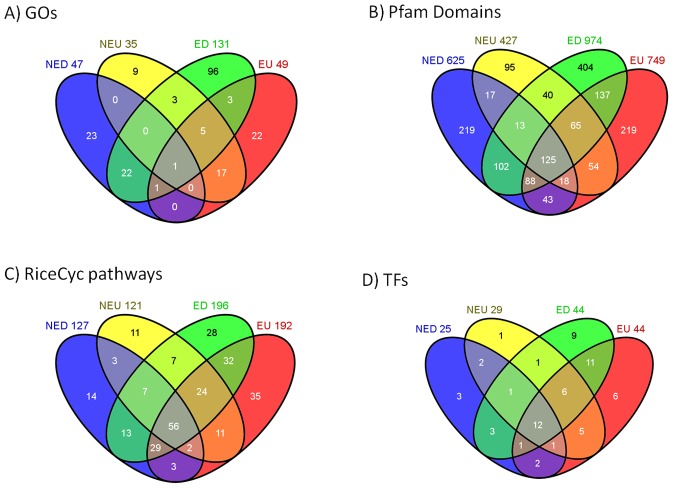
Four way venn diagrams depicting overlap of different characteristics between the clusters NED, NEU, ED and EU.A) GO terms analyzed by AgriGO, B) Protein domain families as per Pfam database, C) Metabolic pathways by RiceCyc and D) Types of transcription factors as reported by PlnTFDB.